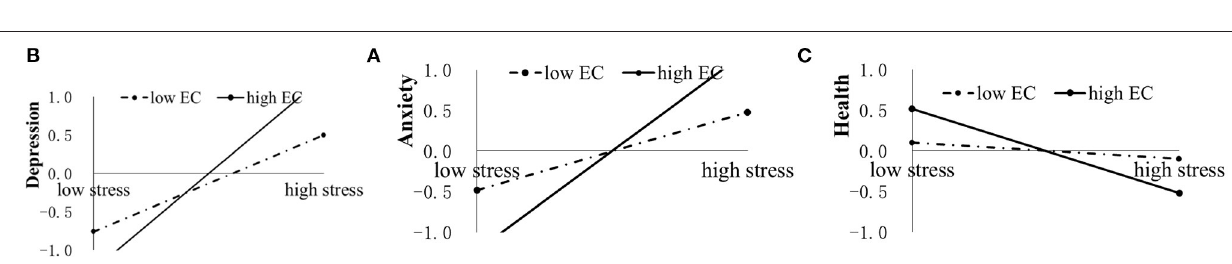
FIGURE 1 | The impact of COVID-19-related stressors (stress) on anxiety (A) and depression (B) moderated by problem-based coping (PC).